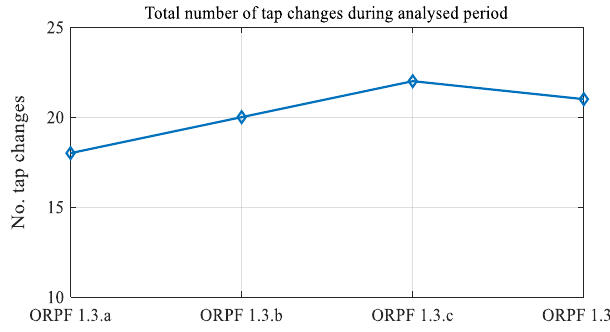
Figure 25. ORPF computation times statistics: ( a ) complete histogram; ( b ) detail of histogram. Figure 26. ORPF Configuration 1 tap changes during analyzed period. Figure 26. ORPF Configuration 1 tap changes during analyzed